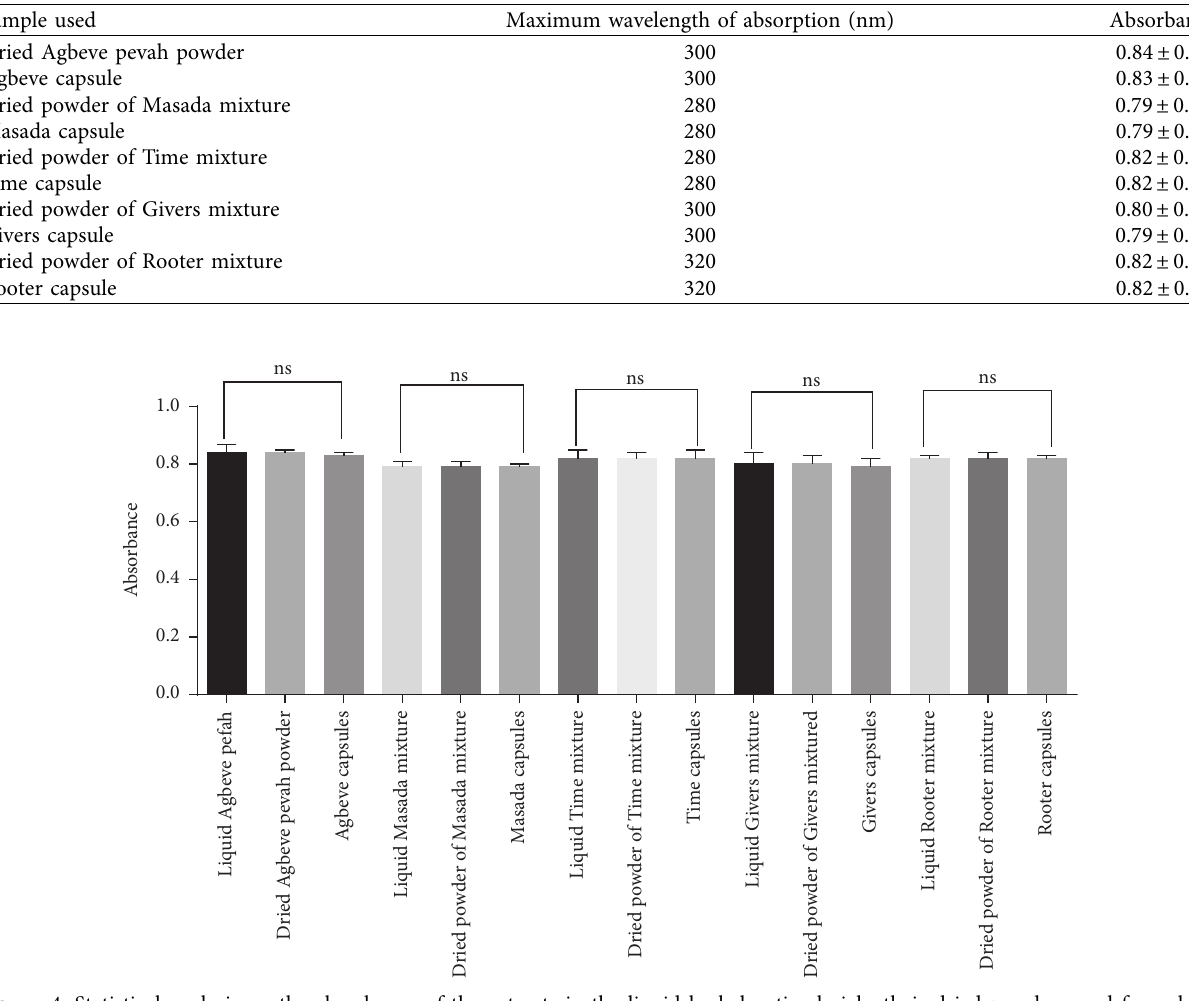
Table 3: Maximum wavelength and corresponding absorbance for a dose of dried powder from the liquid herbal antimalaria and one capsule (dose) of the formulated herbal